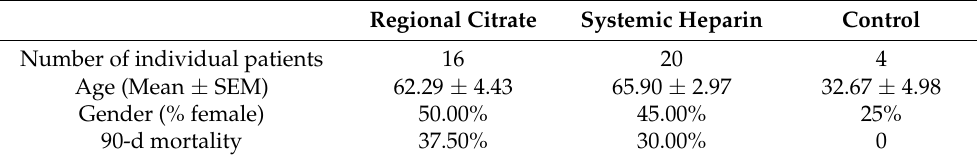
Table 1. Patient characteristics.